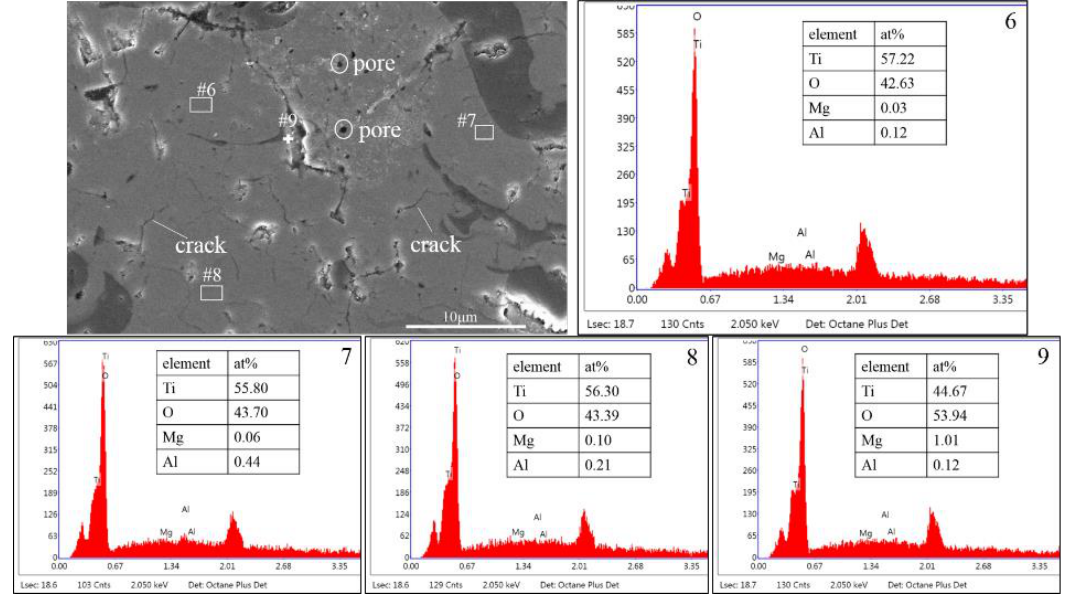
Figure 11. Cross-sectional morphology of electrical-heating coating after cyclic electricity test and EDS analysis.